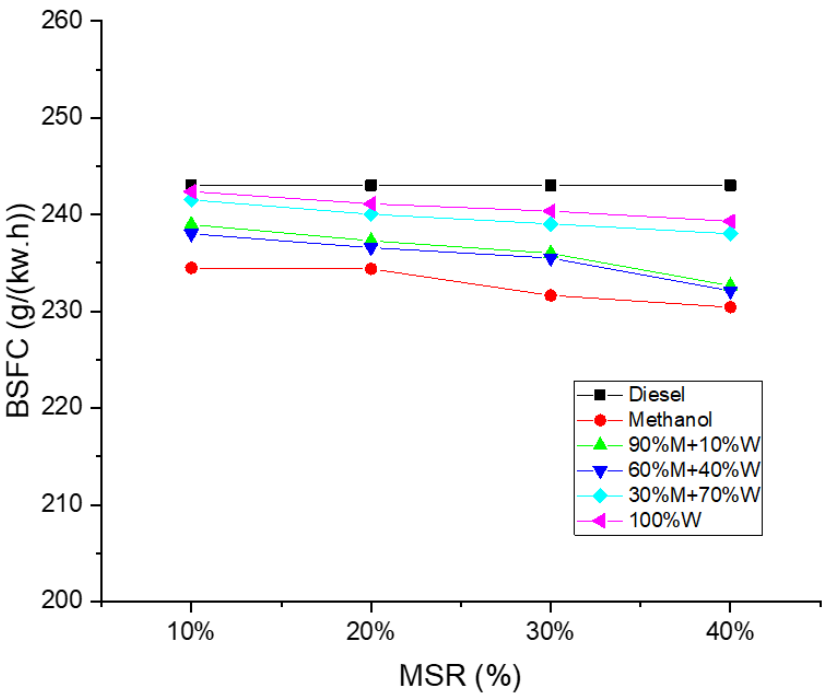
Figure 4. Changes of diesel BSFC under different mixing ratios.